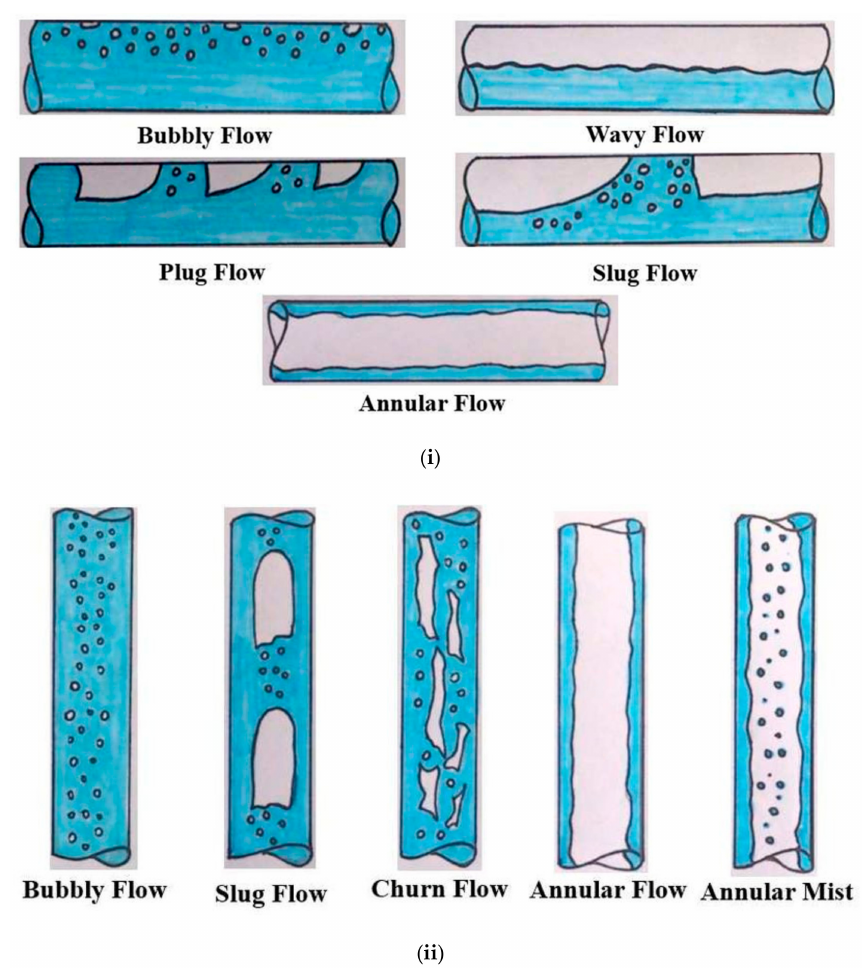
Figure 2. Flow patterns in pipelines. ( i ) Flow patterns of near-horizontal pipeline [50]. ( ii ) Flow patterns of near-vertical flow